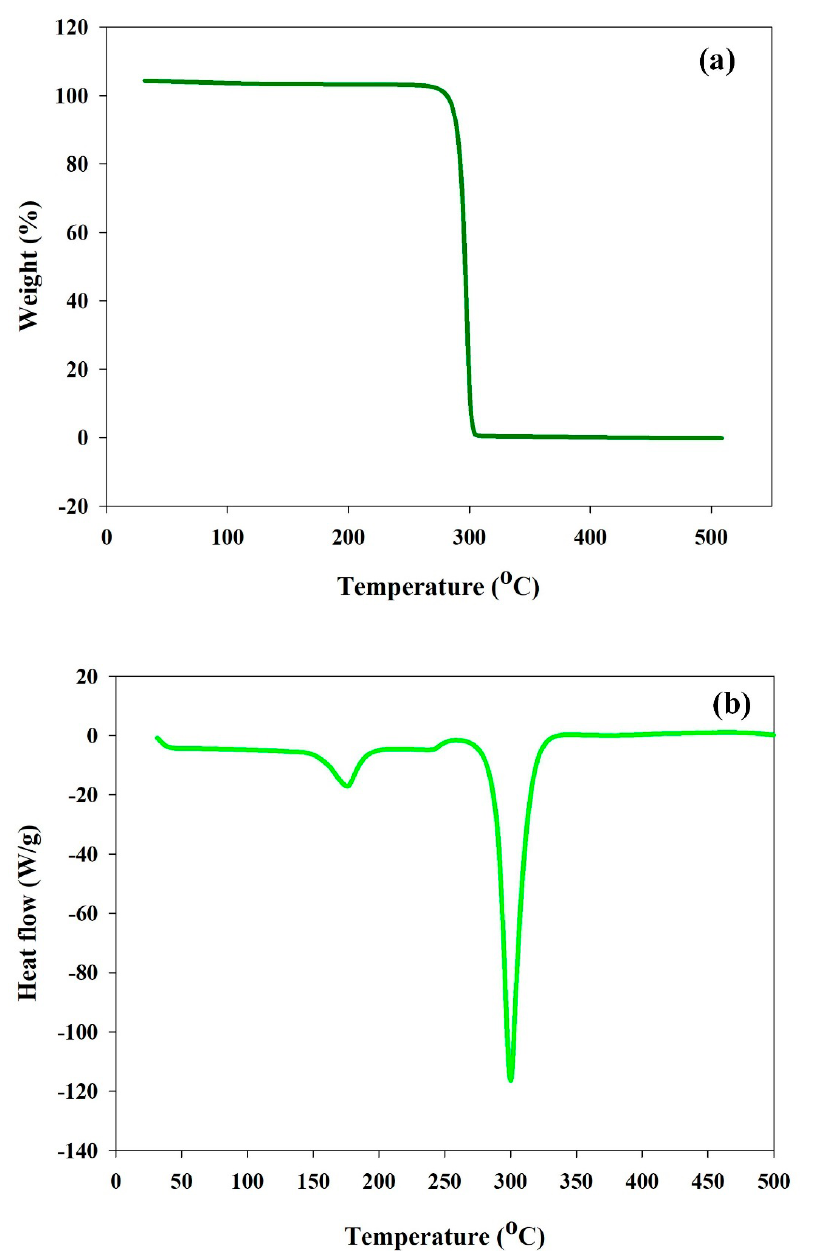
Figure 7. ( a ) Thermo gravimetric analysis (TGA) and ( b ) differential scanning calorimetry (DSC) analysis of the PHB produced by Ralstonia eutropha using alkaline pretreated WH hydrolysates.